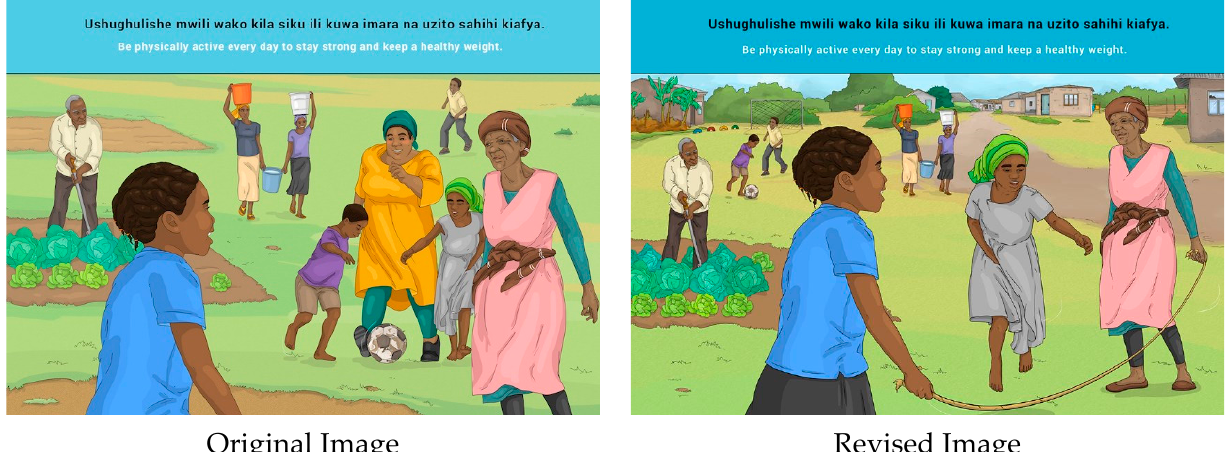
Figure 19. Be physically active every day to stay strong and keep a healthy weight.